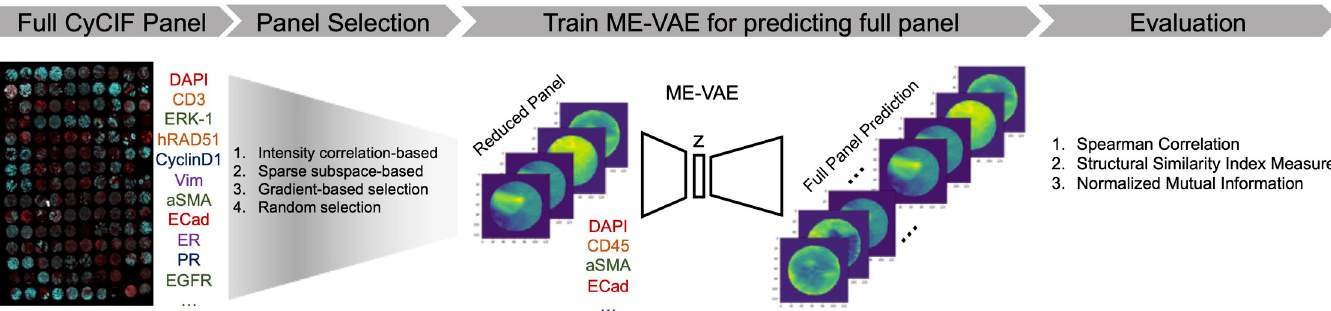
Fig 1. An illustrative schema for panel reduction and prediction: In order to select an optimally reduced panel from a designed full panel, four different selection methods were tested: intensity correlation-based, sparse subspace-based, gradient-based, and random selection. Using the reduced panels selected from each method, a ME-VAE was used to impute the full panel set. The full set of imputations were then evaluated by comparing them to the original images using important features of downstream analyses such as mean intensity correlations, structural similarity index measure, and cluster overlap using Normalized Mutual Information.